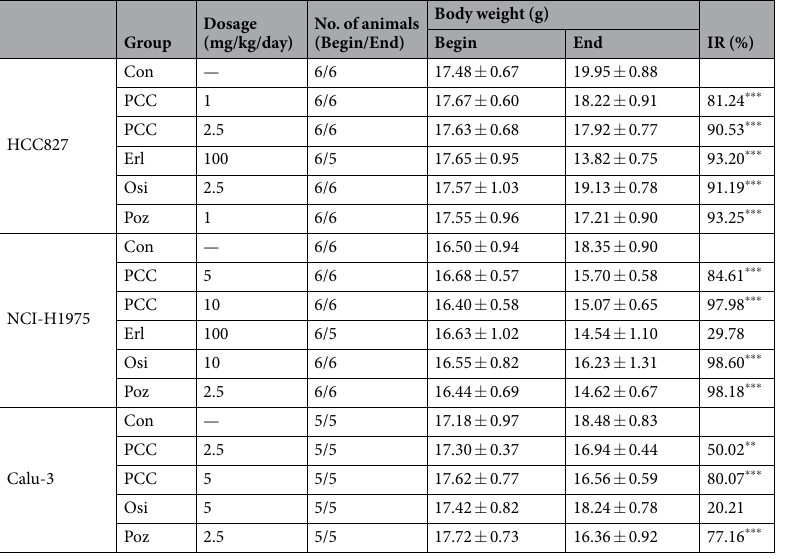
Table 3. The anti-tumor activity of PCC0208027 in NSCLC xenograft models. ** P < 0.01, *** P < 0.001, compared to the control